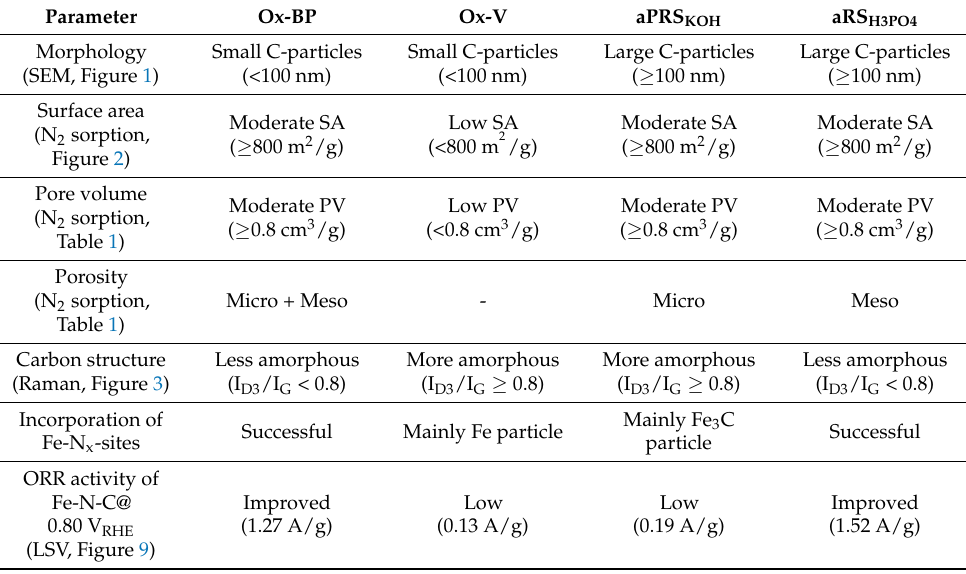
Table 2. Summary of physical properties of four different carbon supports influencing Fe-N x site incorporation, including results of morphology analyzed by SEM, specific surface area as well as porosity determined by N 2 sorption and carbon structure evaluated by Raman spectroscopy.